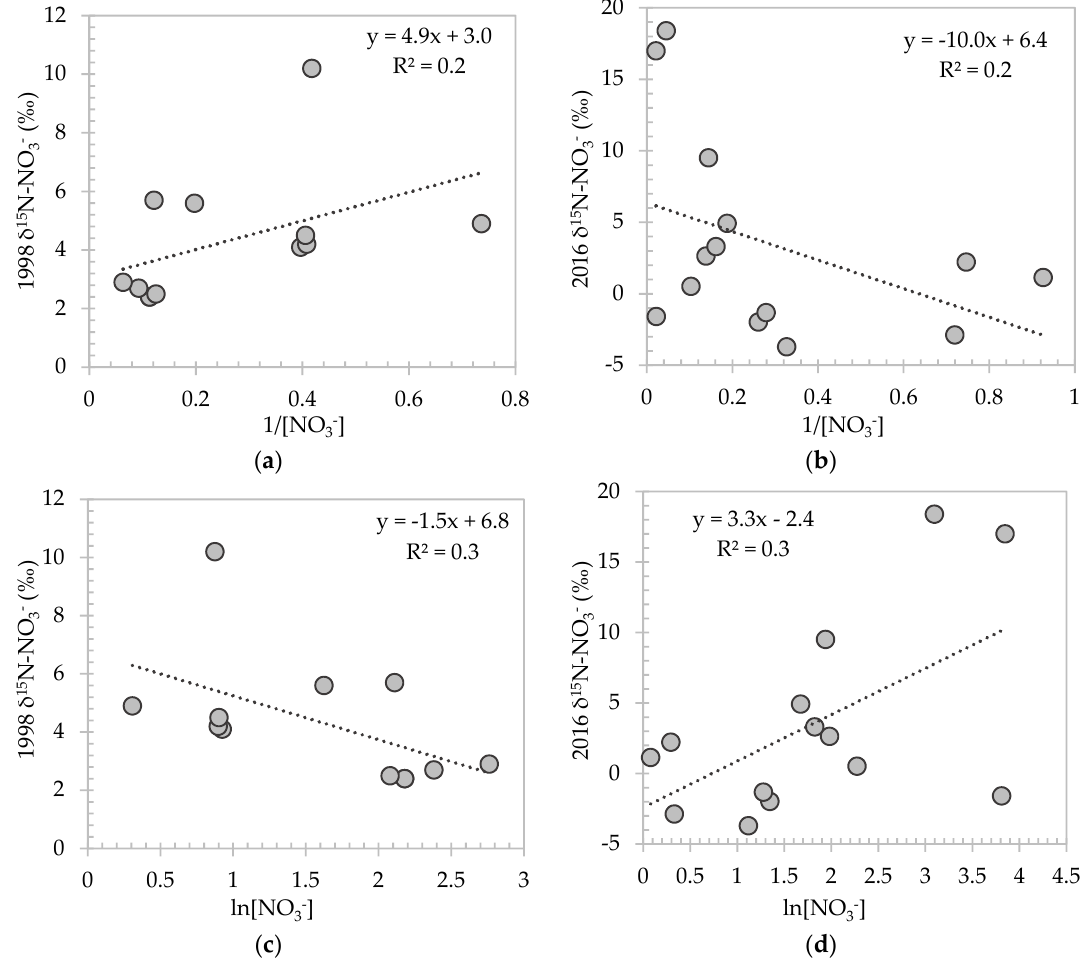
Figure A3. Evaluating whether δ 15 N ‐ NO 3 − suggests processes of mixing high ‐ and low ‐ [NO 3 ] groundwater in: ( a ) 1998; and ( b ) 2016; or groundwater denitrification in: ( c ) 1998; and ( d ) 2016 [64]. Simple groundwater mixing nor denitrification were indicated from the composition of nitrogen isotopes throughout the Dutch Flats.